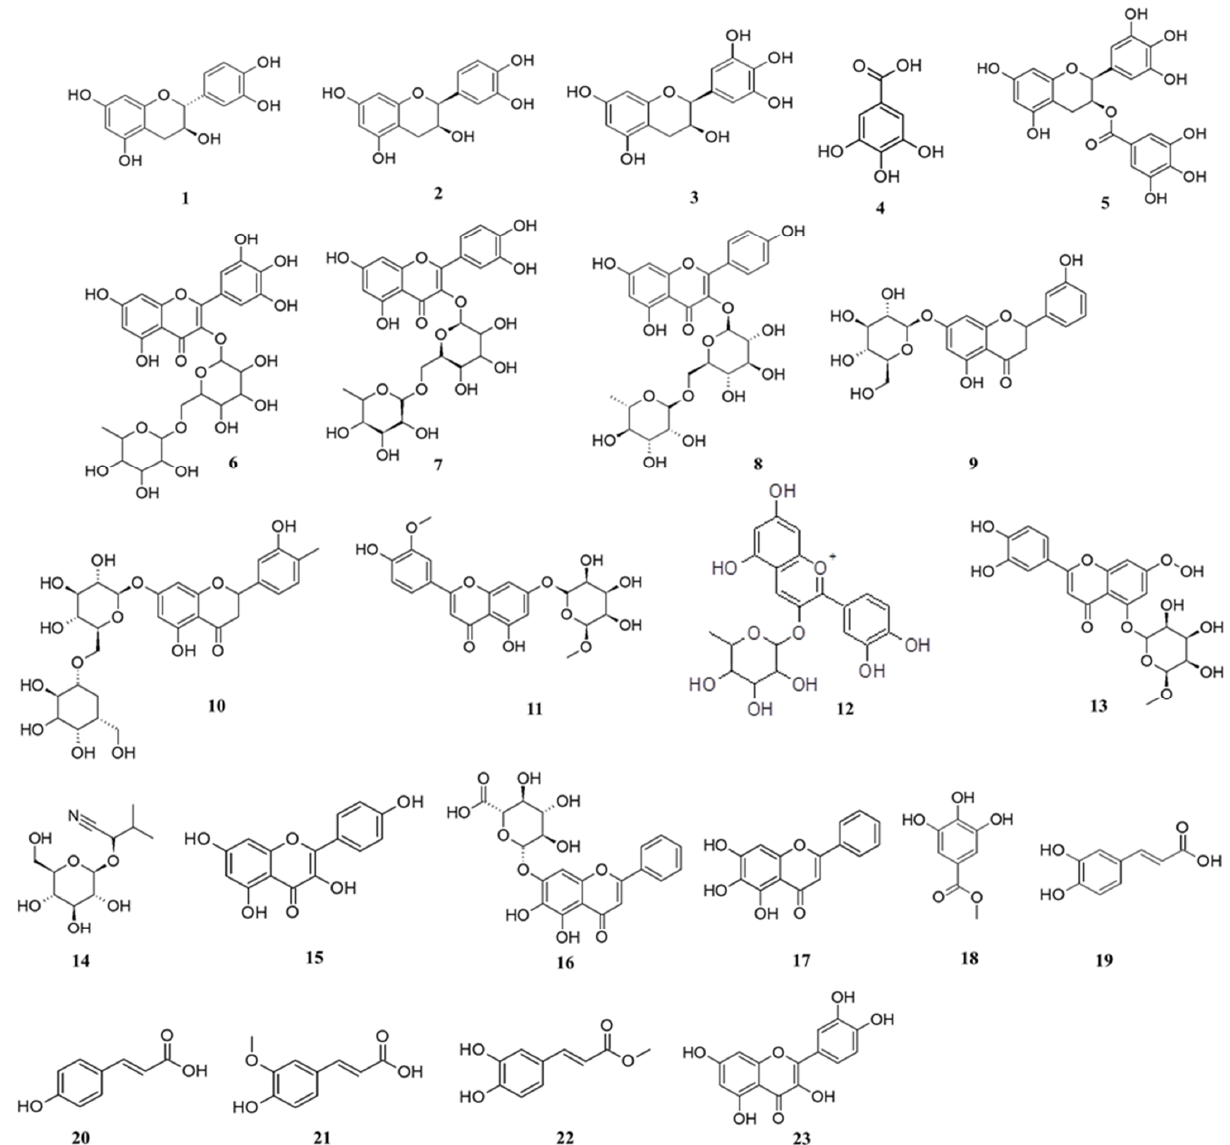
Figure 6. Chemical structures of metabolites annotated from Vachellia species.